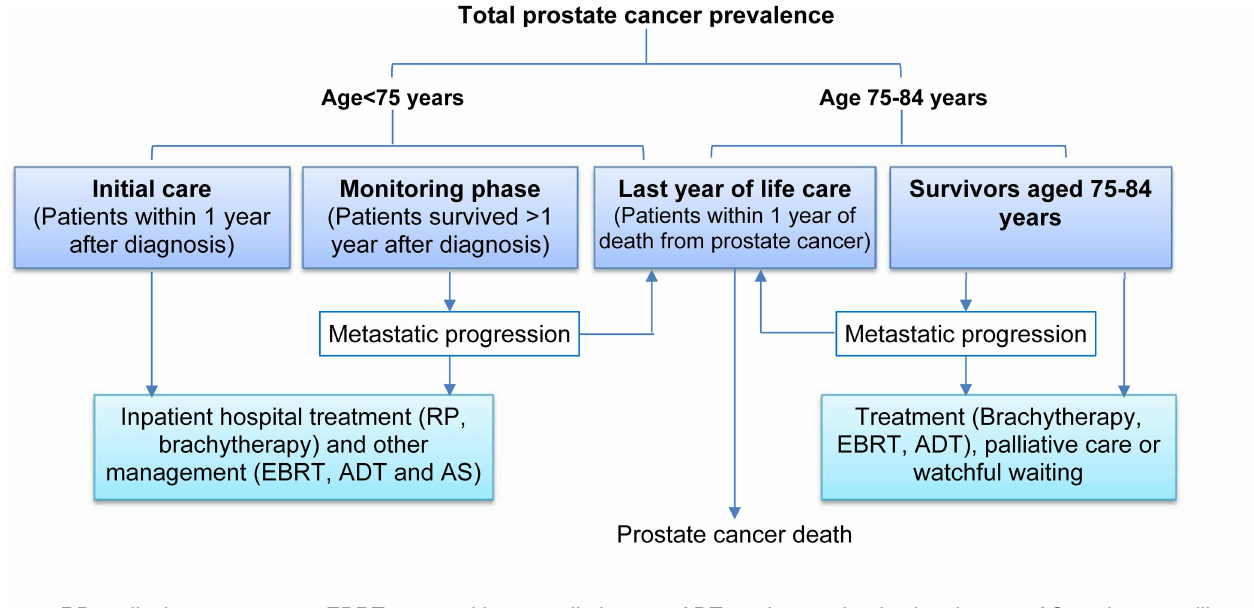
Fig 1. Prostate cancer phases of care. Patients who died from other causes were excludedfrom the prevalence